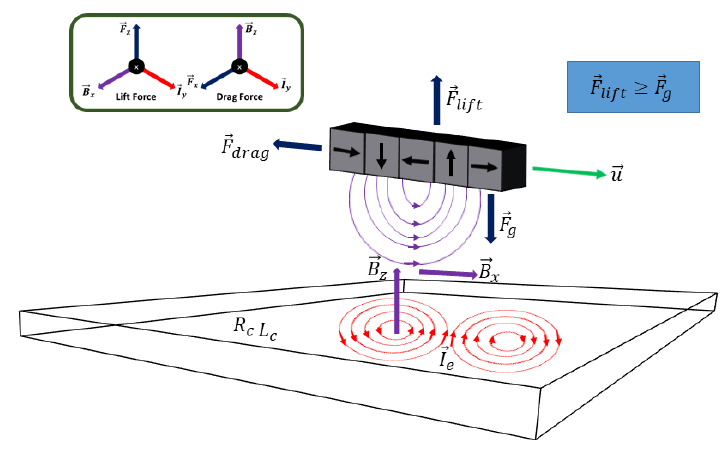
Figure 6. An overview of the passive maglev system for a traveling arrangement of permanent magnets along a conducting track.